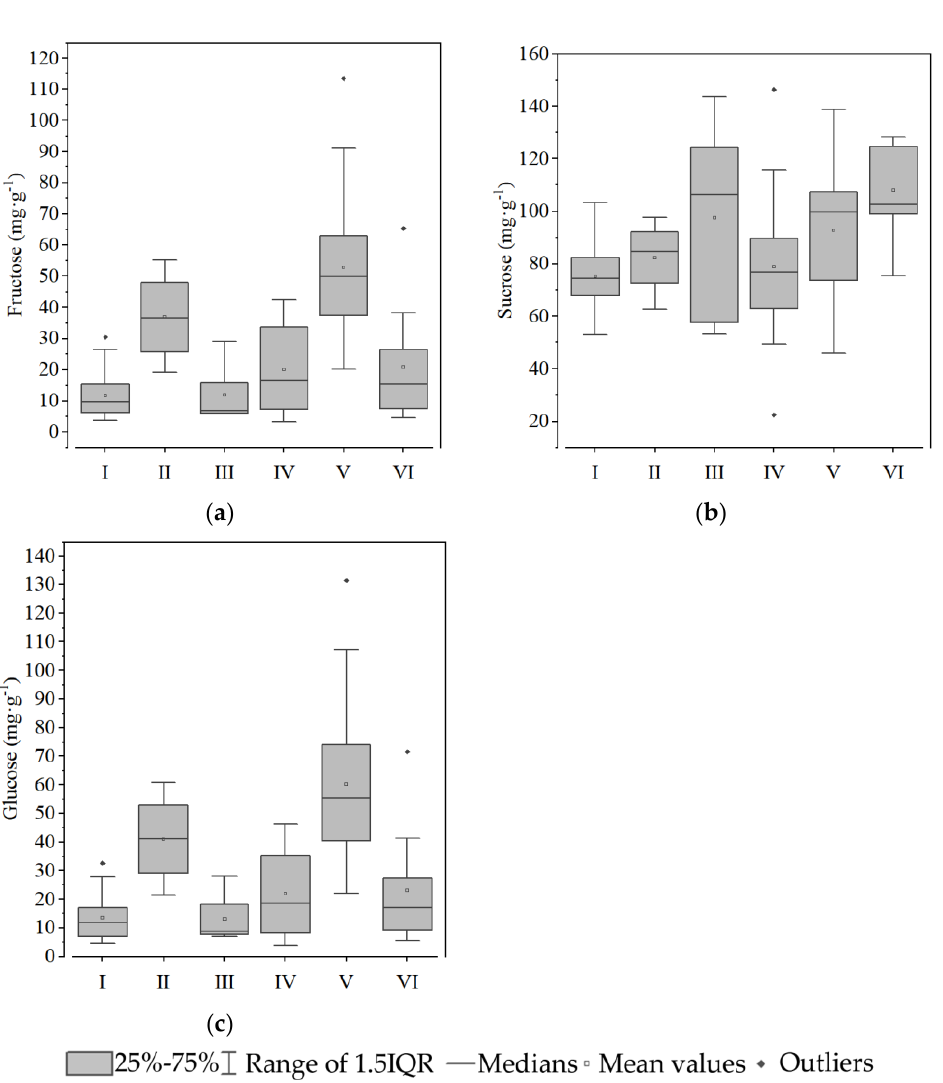
Figure 4. Soluble sugar components of the tuberous roots of six groups of sweet potato: ( a ) fructose; ( b ) sucrose; and ( c ) glucose. White squares indicate mean values. Rhombuses indicate outliers.